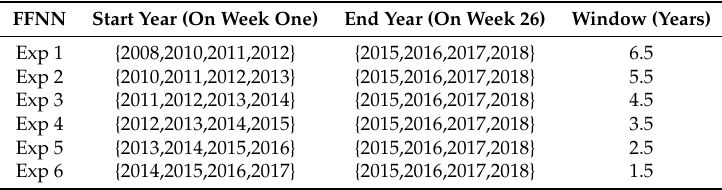
Table 3. Training sets. Each test consisted of twelve experiments, six with retraining and six without retraining the network.